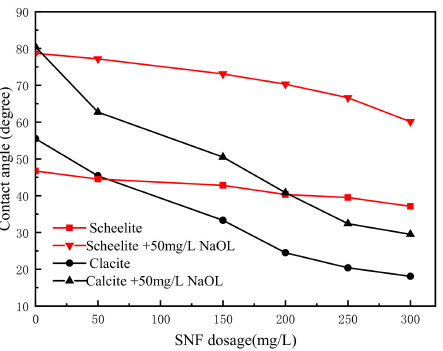
Figure 7. Contact angles vs. SNF dosage in the presence and absence of 50 mg/L NaOL at pH